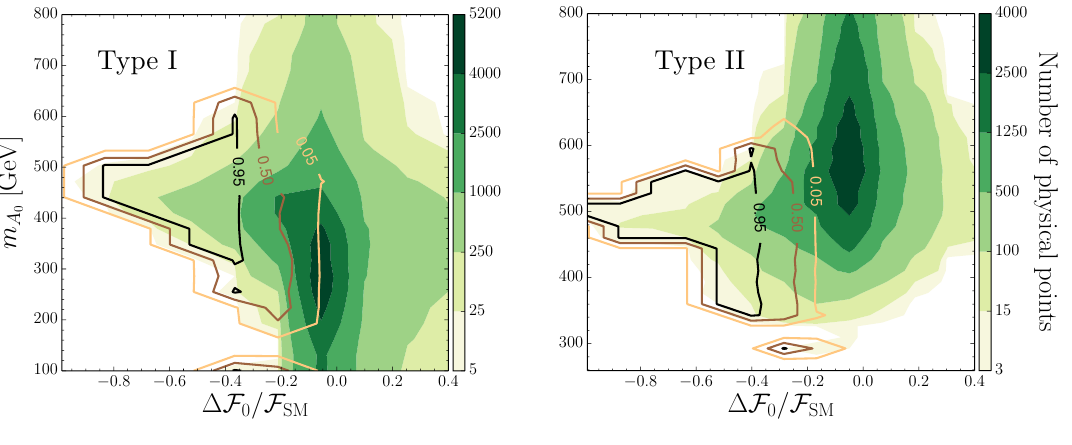
Figure 4 . Distribution of physical points and where the